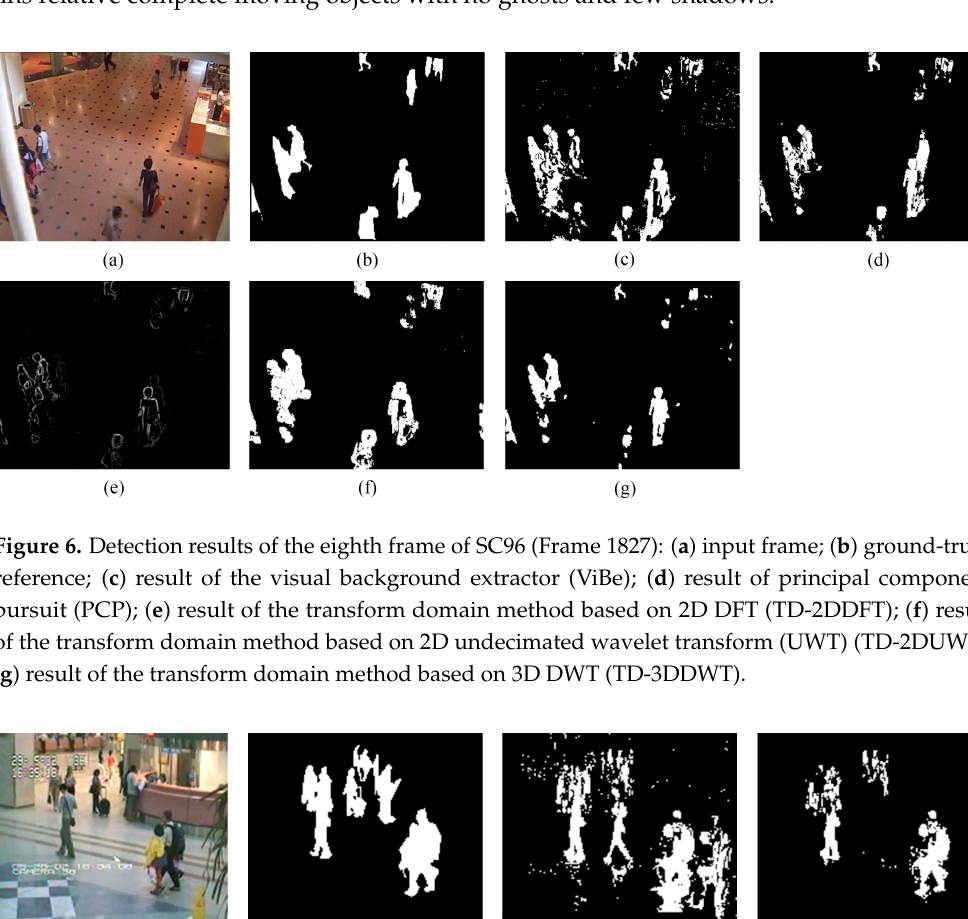
Figure 8. Detection results of the ninth frame of BR96 (frame 1558): ( a ) input frame; ( b ) ground-truth reference; ( c ) result of ViBe; ( d ) result of PCP; ( e ) result of TD-2DDFT; ( f ) result of TD-2DUWT; ( g ) result of TD-3DDWT. Figure 9. Detection results of the 49th frame of SK96 (Frame 1953): ( a ) input frame; ( b ) ground-truth reference; ( c ) result of ViBe; ( d ) result of PCP; ( e ) result of TD-2DDFT; ( f ) result of TD-2DUWT; ( g ) result of TD-3DDWT.